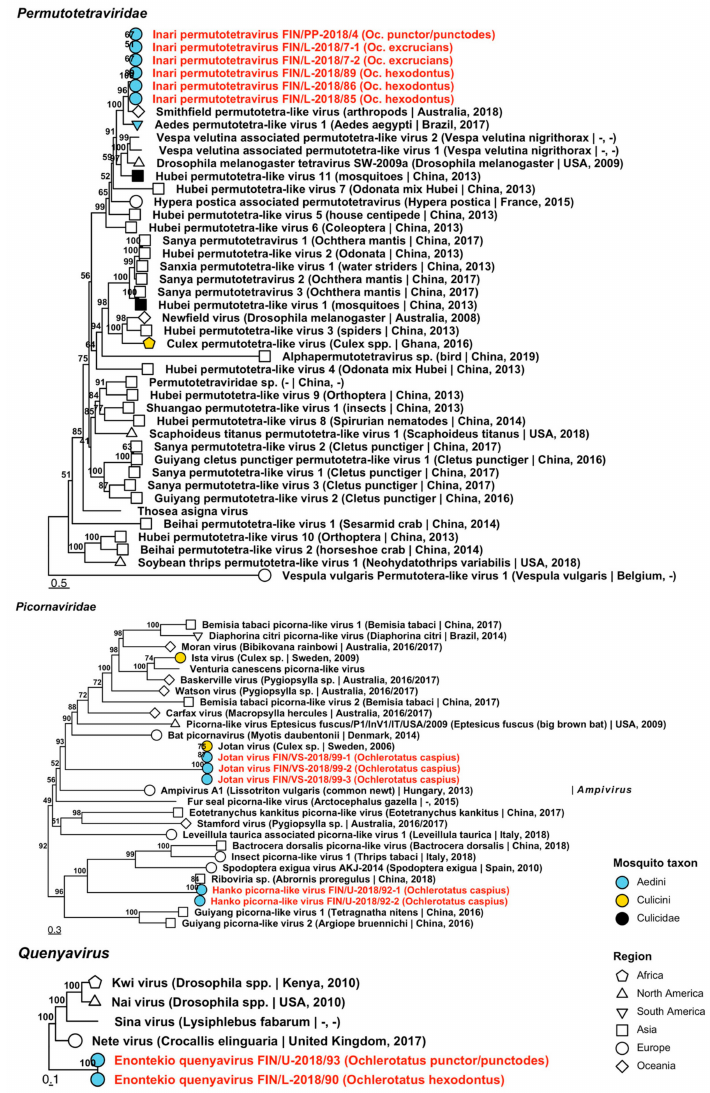
Figure 6. Maximum likelihood trees of Permutotetraviridae , Picornaviridae and Quenyavirus . Tentative novel viruses are displayed in red and the mosquito species from which they were derived are in parentheses. Sequences from GenBank are black and display the following information after the virus or species name: “(sampled organism(s)|collection country, collection year)”. Tip colours represent the tribe of mosquito from which viruses were obtained. Tip shape represents the continent or region from which the specimens were collected. Trees were constructed from amino acid sequences of virus polymerases >1000 nt, aligned with MAFFT and computed with IQ-TREE2 using ModelFinder and 1000